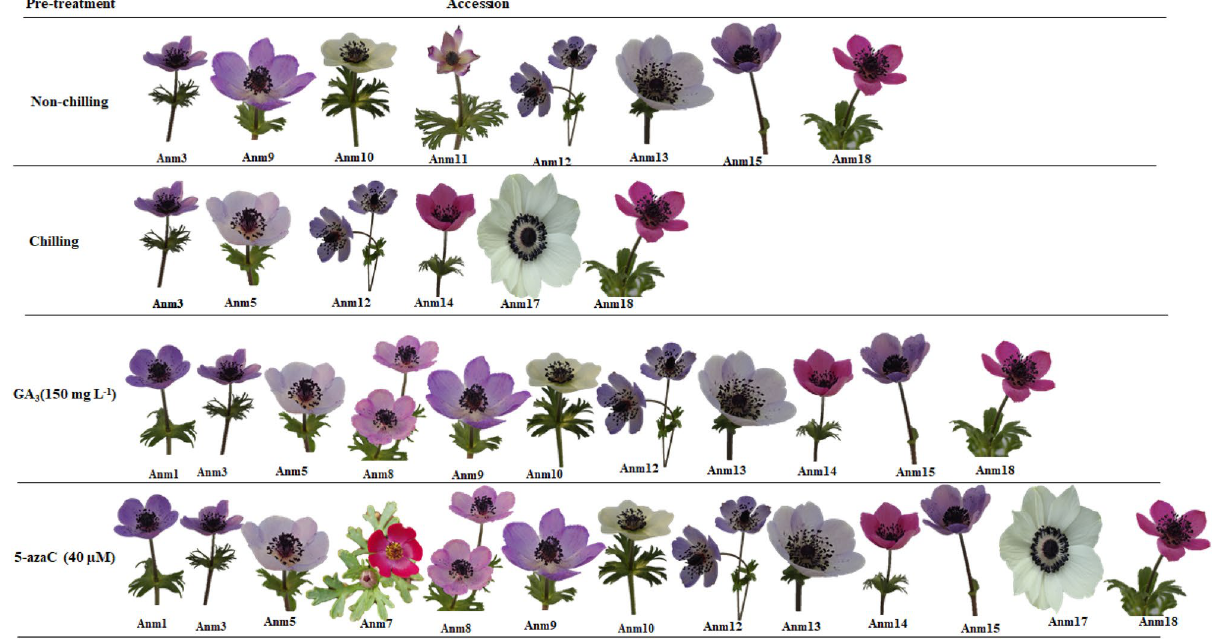
Figure 3. Comparison of superior Anemone accessions under different pre-treatment conditions (non-chilling, chilling, 5-azaC and GA 3 ). The flower of each genotype was used as a symbol. By 5-azaC and chilling pre- treatments, the superior group comprised respectively the highest (13) and lowest (6) number of accessions which presented relatively the most desirable value of the traits among the groups. (Images were prepared in Microsoft PowerPoint,